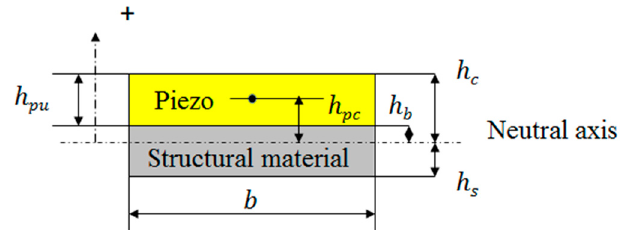
Figure 5. Scheme of the harvester cross-section.